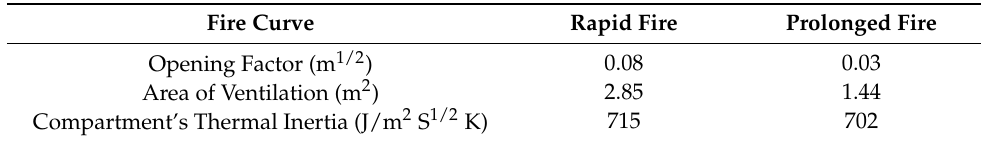
Table 1. Parametric fire curves.